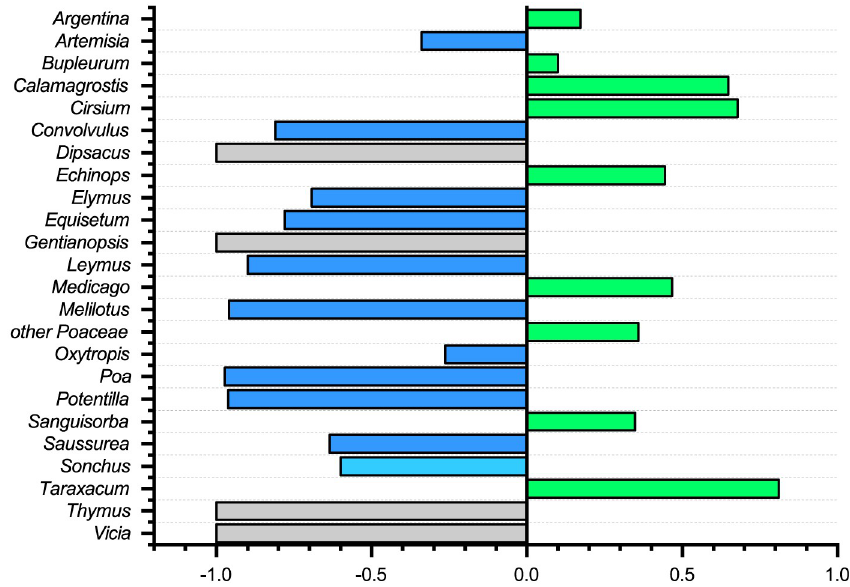
Fig 7. Food selection diagram of zokor. Green represents positive selection; Blue represents negative selection; Grey means no selection.